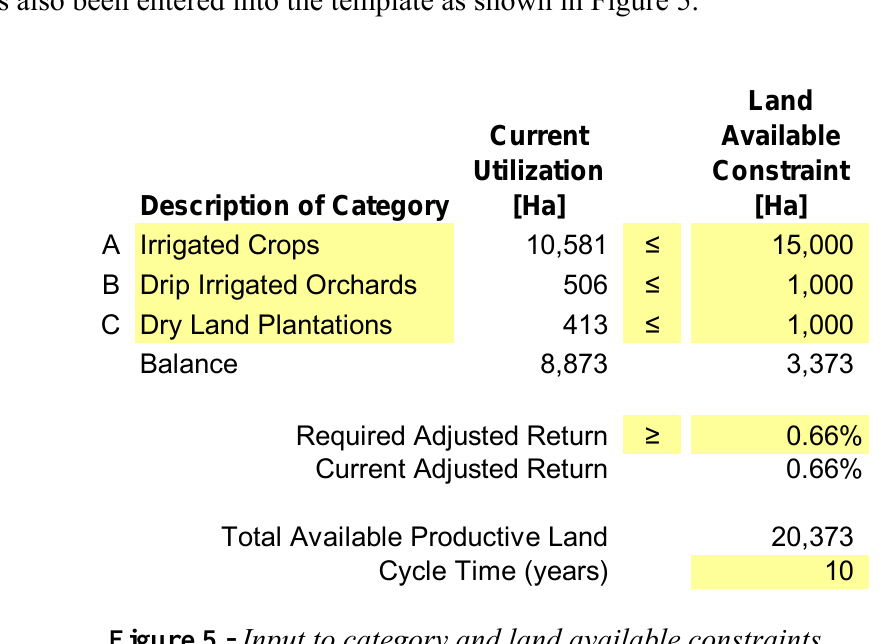
Figure 5 - Input to category and land available